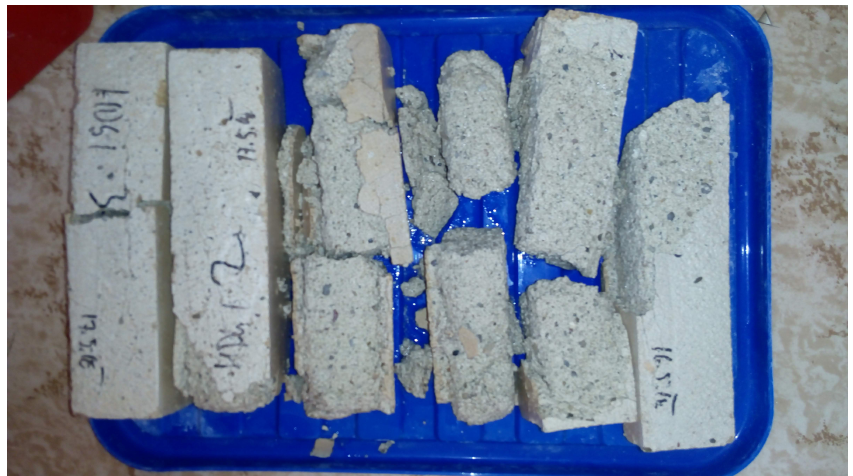
Figure 4. DG 1 and DG 5 (three of each from left to right) specimens after durability